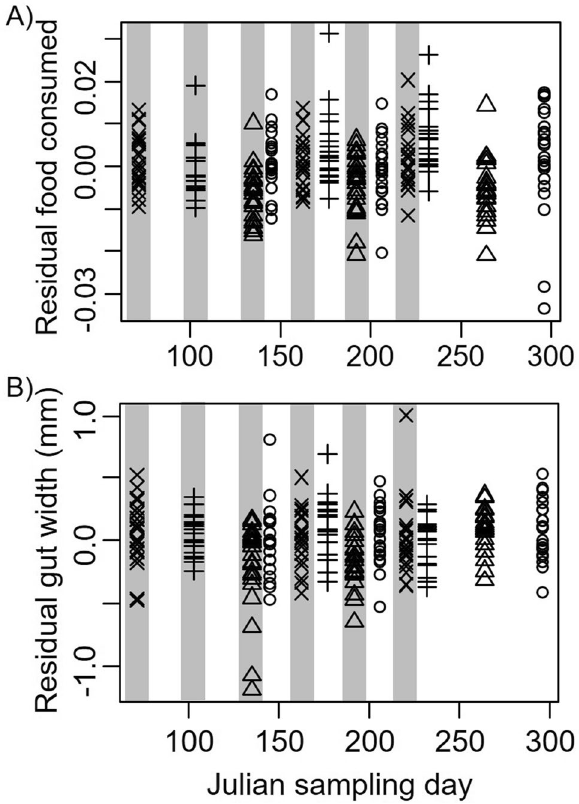
Figure 5. Residual gut mass ( A ) and gut width ( B ) in Aratus pisonii (after accounting for body size) as a function of Julian sampling date, proxies for the amount and quality of food consumed, respectively. Symbols indicate sampling site, where circles are Round Island, triangles are Oslo, plus sign is North Causeway, and the multiplication sign is Pepper park. Gray shaded sampling dates indicate periods of new moon, while white indicates full